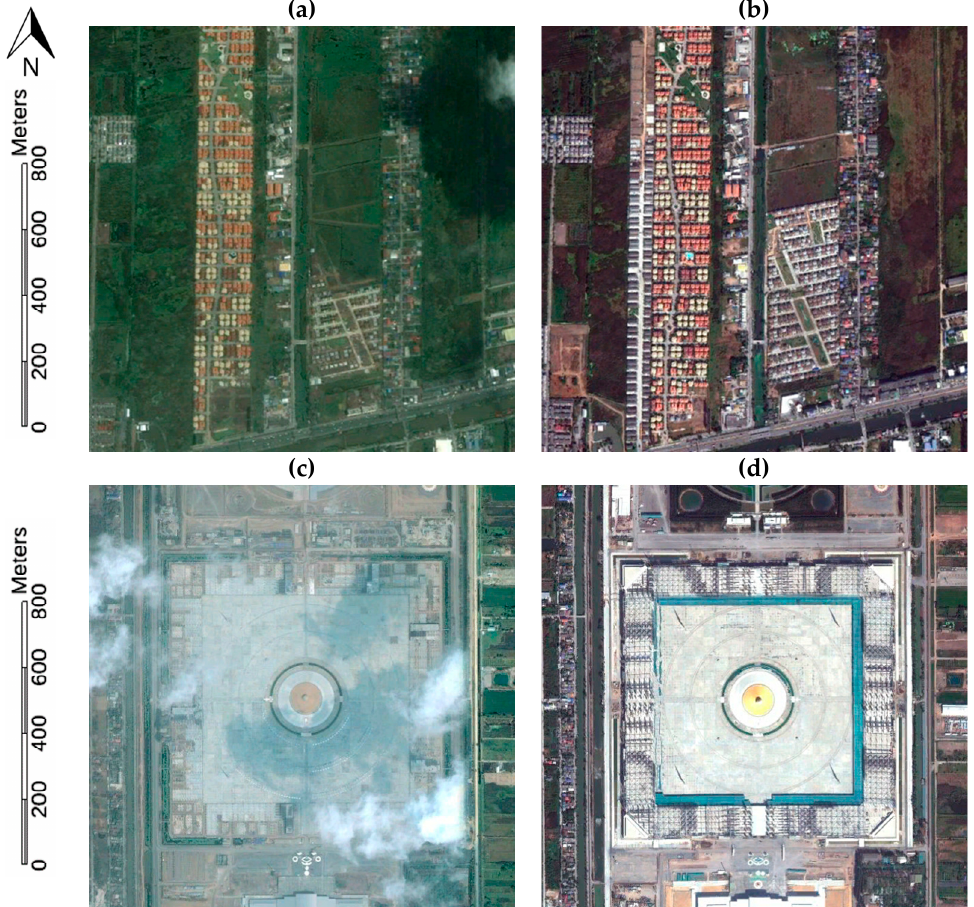
Figure 3. Optical image showing an example of new constructions of Bangkok testing area. The size of each image is 1.3 × 1.3 km. (a) Time 1 image of first testing area from 22 August 2008, (b) Time 2 image of first testing area from 18 December 2009, (c) Time 1 image of second testing area from 10 February 2005, (d) Time 2 image of second testing area from 18 December 2009.